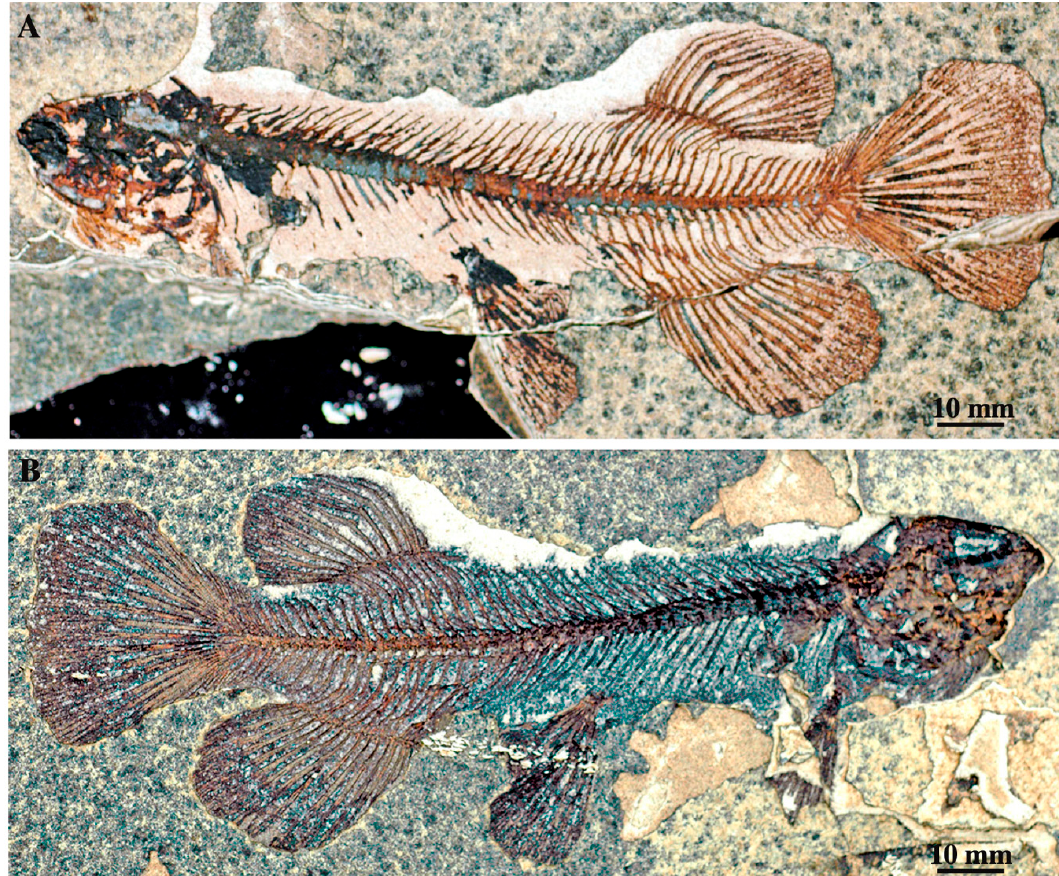
Figure 2. Foulden Maar, early Miocene. Galaxias e ff usus Lee, McDowall & Lindqvist 2007. ( A , B ), Part and counterpart of holotype (OU22650).